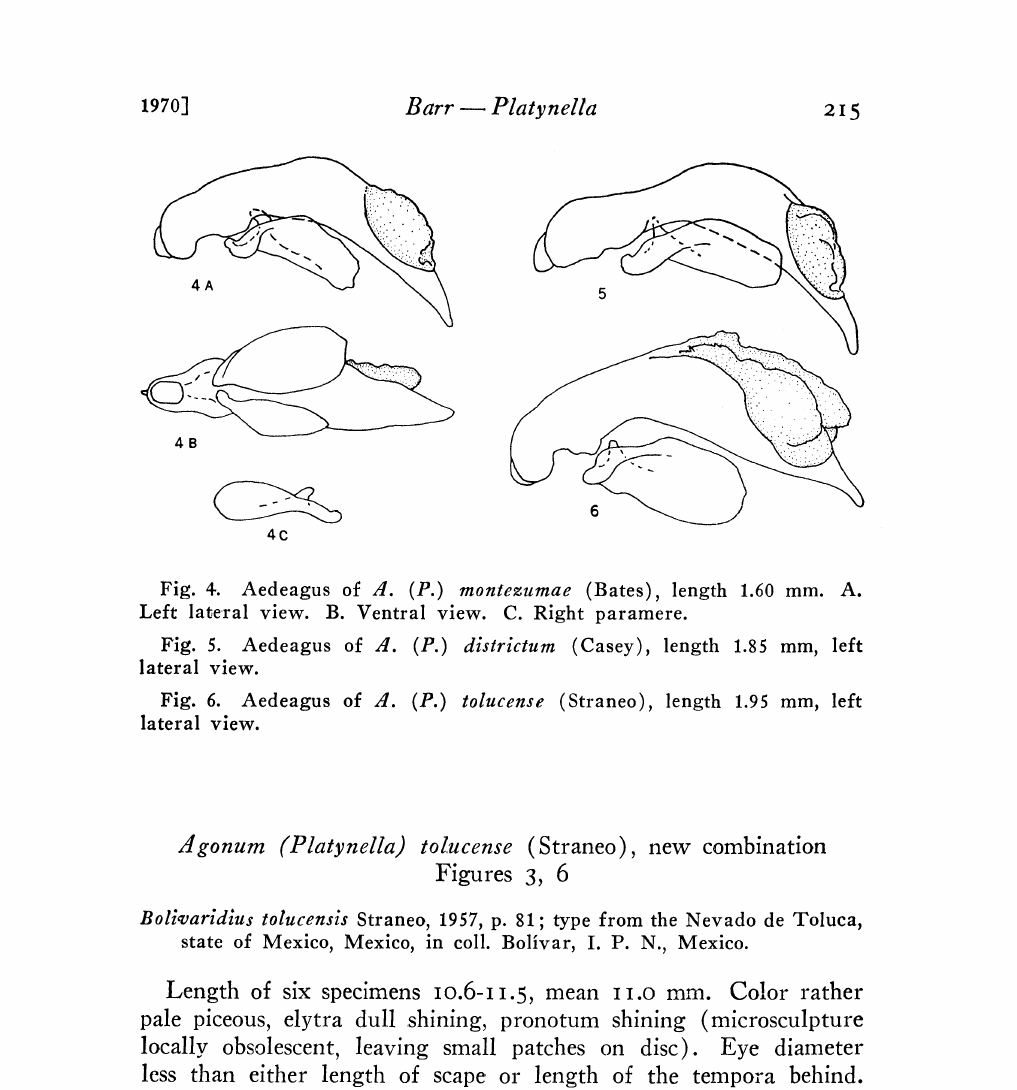
A gonum (Platynella) tolucense (Straneo), new combination Figures 3,